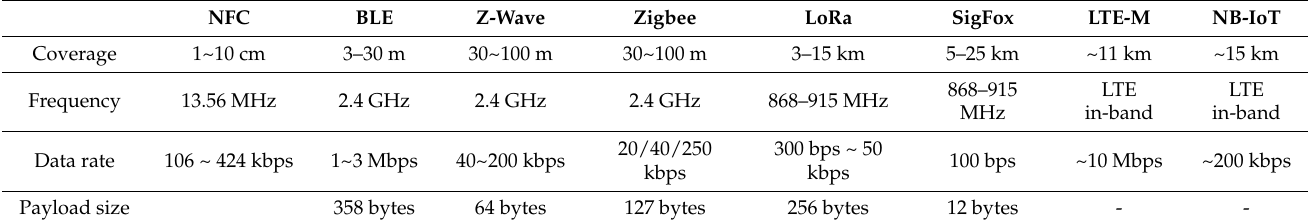
Table 2. Key features of IoT network